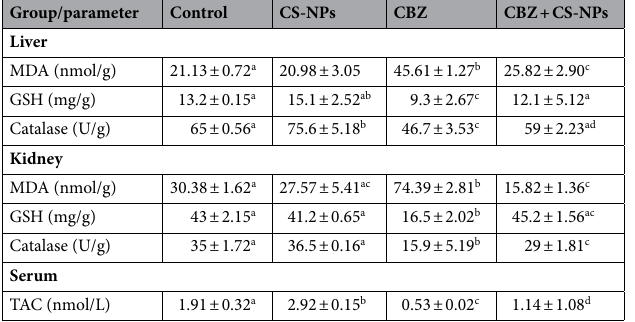
Table 4. The effect of carbendazim (CBZ) and/or chitosan nanoparticles (CS-NPs) on some oxidative stress markers. All data are presented as mean ± SEM (n = 5 rats/ group). Values bearing different superscripts (a, b, c) at the same row means significant at P ≤